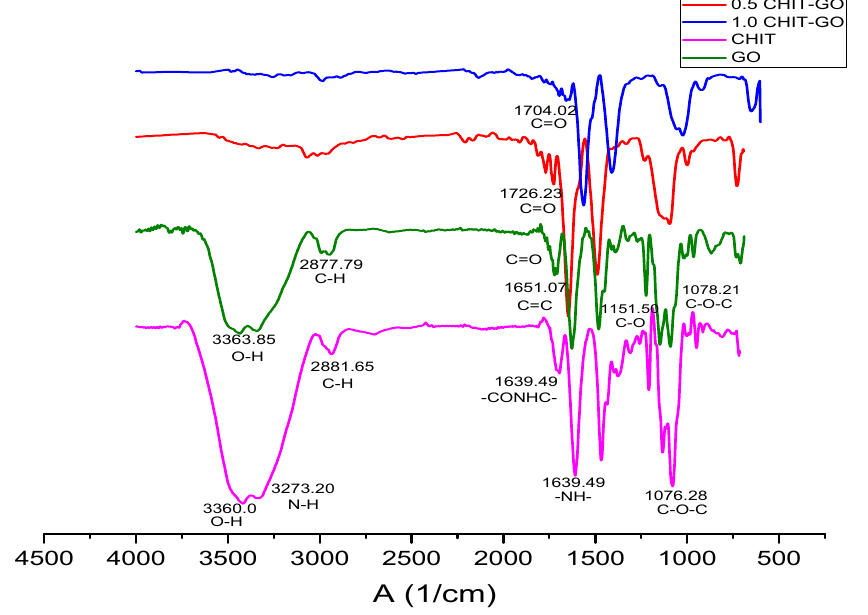
Figure 5. Fourier transform infrared spectroscopy (FTIR) spectrum of the chitosan/graphene oxide (CS/GO) scaffolds synthesized.